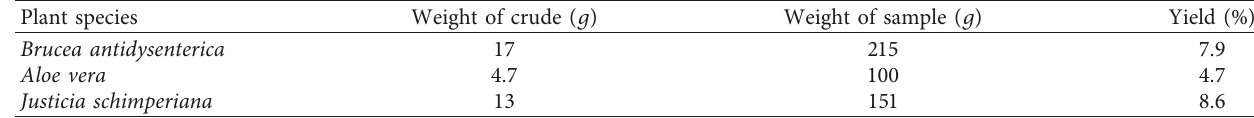
Table 1: Results of percentage yield of plant crude extracts with methanol.